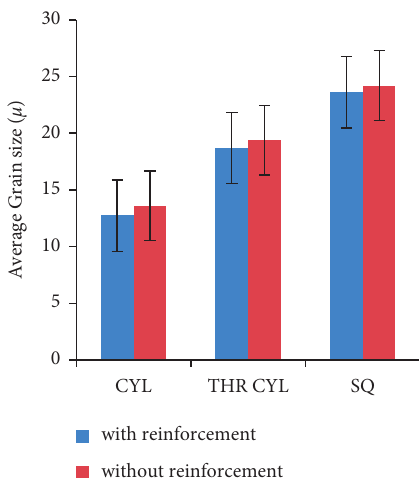
Figure 13: Grain size with operating